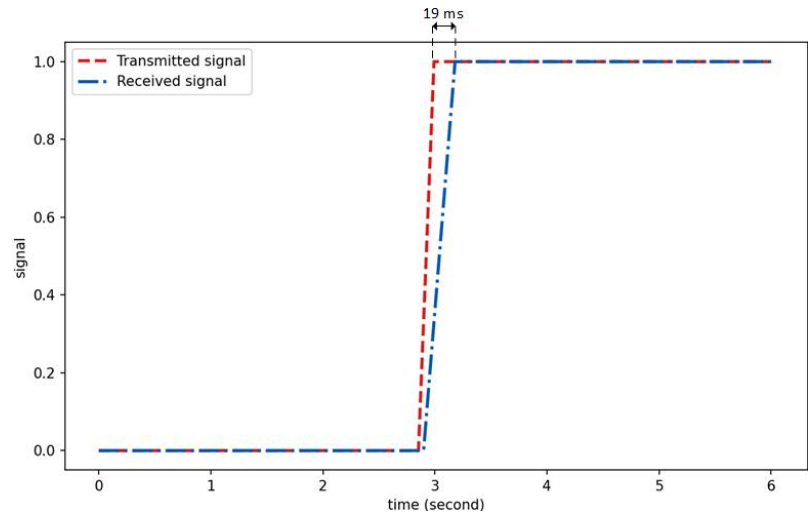
Figure 18. Propagation delay: Bangladesh to Japan and Japan to Bangladesh.